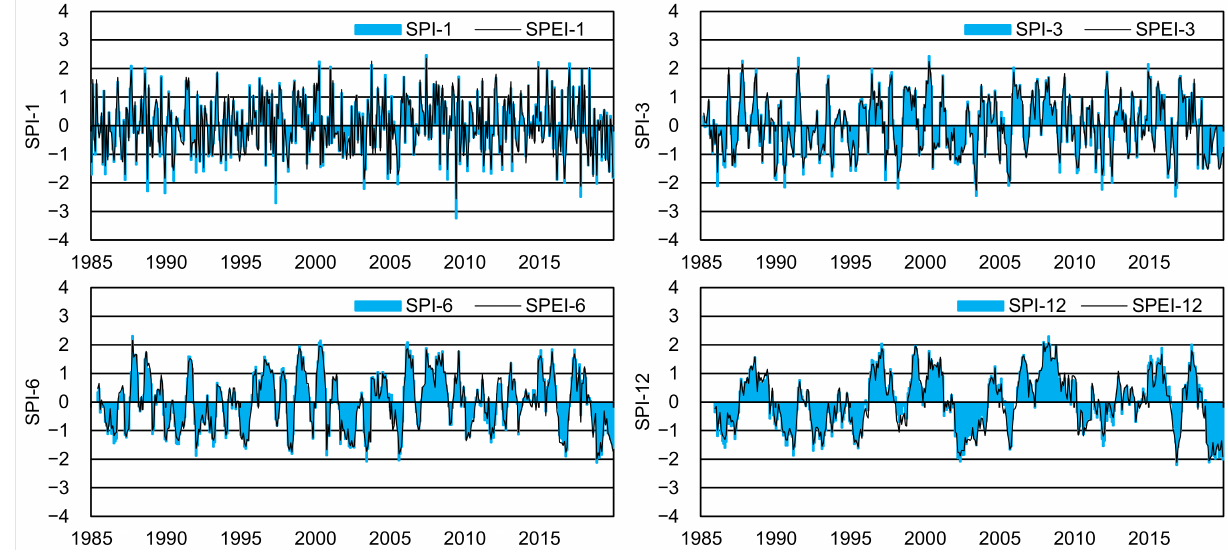
Figure 9. Comparison of the SPI and SPEI at 1-, 3-, 6-, and 12-month timescales at the Ampangan Muda station from 1985 to 2019. Table 7. Comparison of the SPI and SPEI in estimating frequency, average duration, average peak, average severity, and average intensity of droughts at 1-, 3-, 6-, and 12-month timescales. SPI SPEI